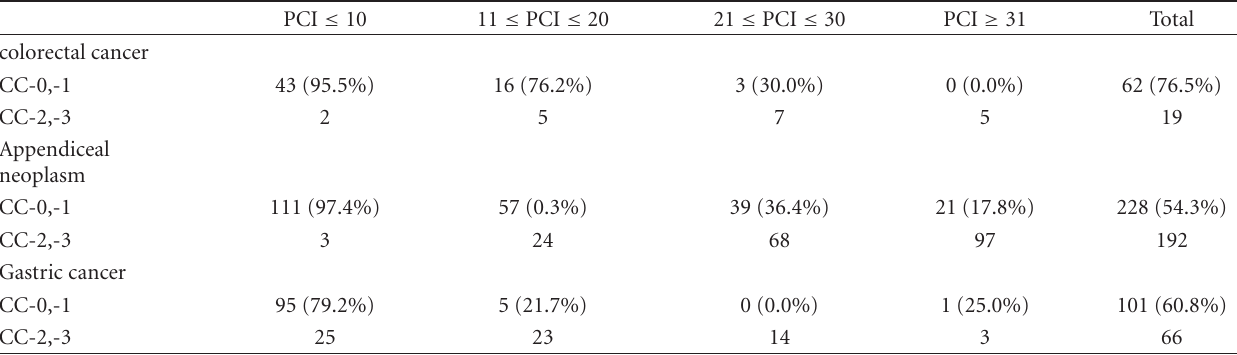
Table 1: Correlation of CC scores and PCI scores.